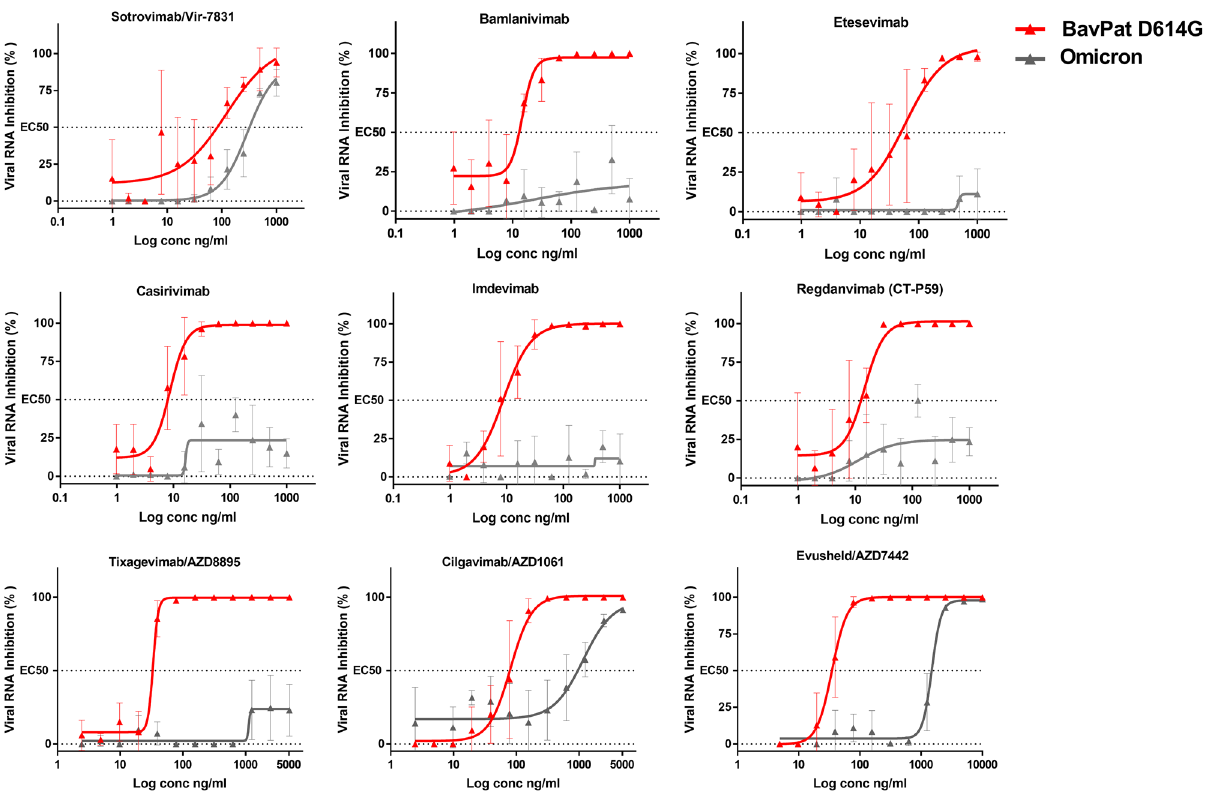
Figure 1. Dose response curves reporting the susceptibility of the SARS-CoV-2 BavPat1 D614G ancestral strain and Omicron variant to a panel of therapeutic monoclonal antibodies. Antibodies tested: Casirivimab/ REGN10933, Imdevimab/REGN10987, Bamlanivimab/LY-CoV555, Etesevimab/LY-CoV016, Sotrovimab/ Vir-7831, Regdanvimab/CT-P59, Tixagevimab/AZD8895, Cilgavimab/AZD1061 and Evusheld/AZD7742. Data presented are from three technical replicates in VeroE6-TMPRSS2 cells, and error bars show mean ± s.d.